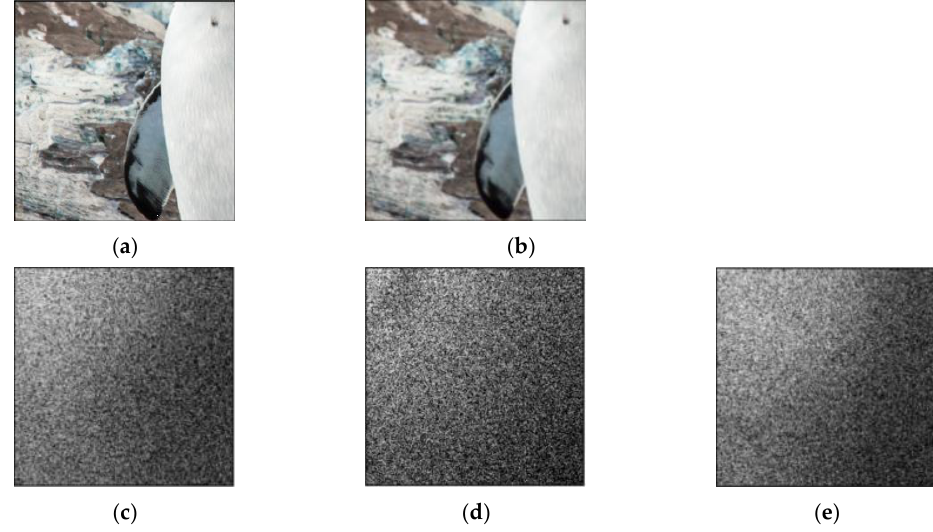
Figure 1. Residual distribution of SteganoGAN in the DCT domain. ( a ) Cover Image; ( b ) Steganographic Image; ( c ) R-channel DCT Domain Residual; ( d ) G-channel DCT Domain Residual; ( e ) B-channel DCT Domain Residual.